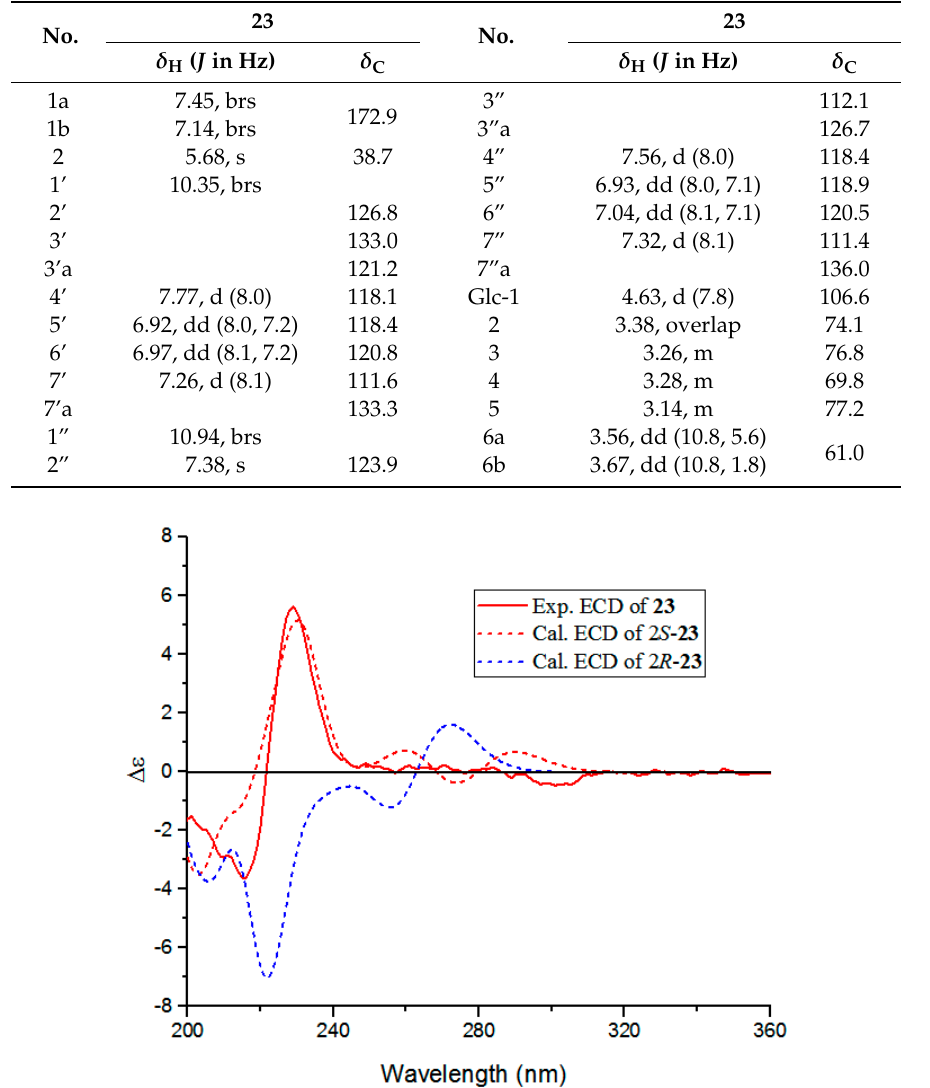
Figure 3. Experimental and calculated ECD spectra of 23. Table 2. 1 H-NMR (600 MHz in DMSO- d 6 ) and 13 C-NMR data (150 MHz in DMSO- d 6 ) of 23.